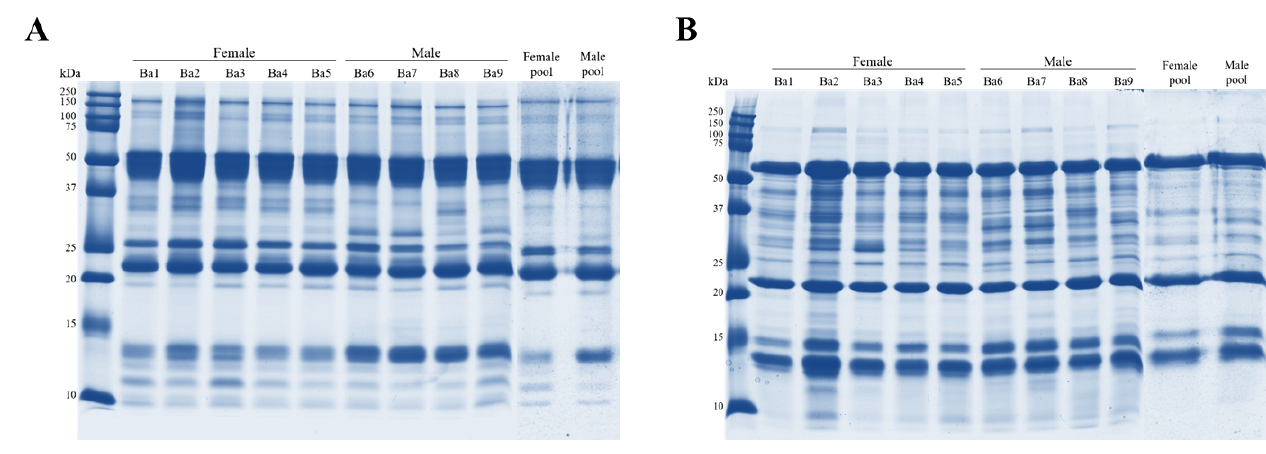
Figure 1. One-dimensional electrophoresis (1-DE) profile of B. atrox venoms under (A) non-reducing and (B) reducing conditions. Individual female (Ba1 to Ba5), male (Ba6 to Ba9) and respective pools were used and are indicated above the